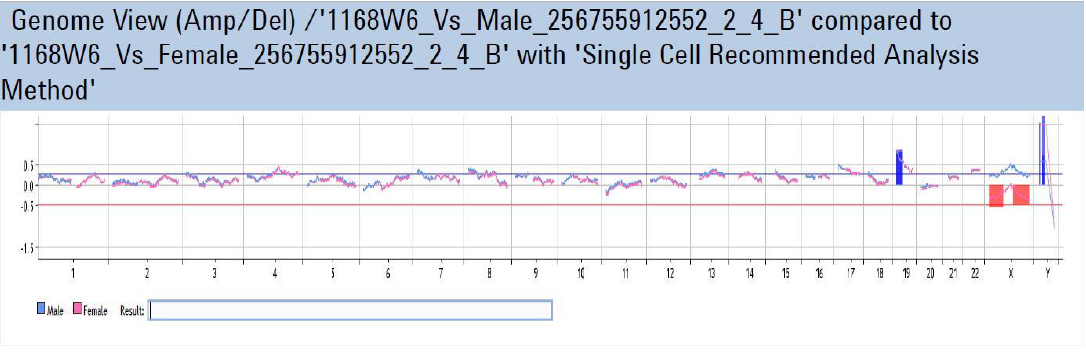
Figure A4. Male embryo, aneuploid, arr. 19p13.3p12(606,030-23,686,458)x3.